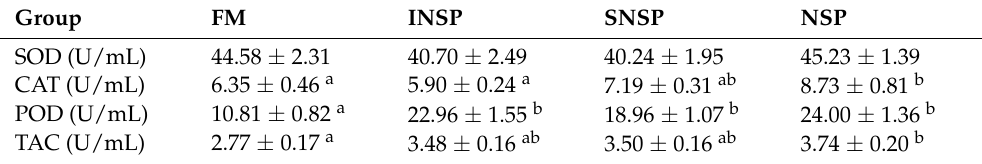
Table 5. Antioxidant capacity of grass carp fed by test